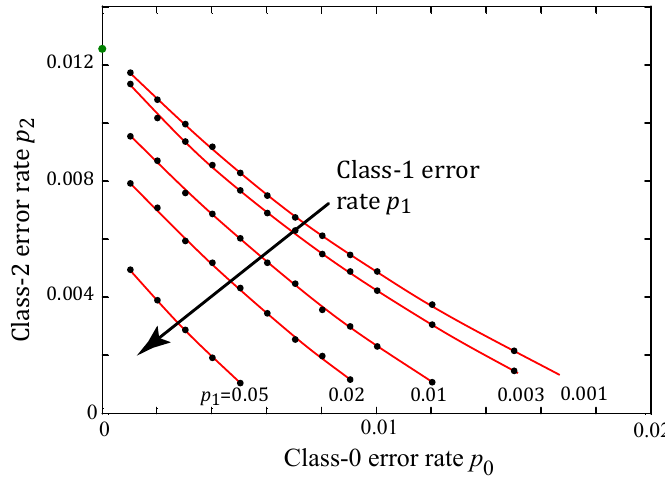
Figure 26: Contours of the three classes’ error rates p threshold, corresponding to the total logical error rate P d = 9 numerical simulation, and lines are guides to the eye. The green dot (upper vertical axis) is the class-2 error rate giving P Ref. (Fowler, Mariantoni, Martinis and Cleland,